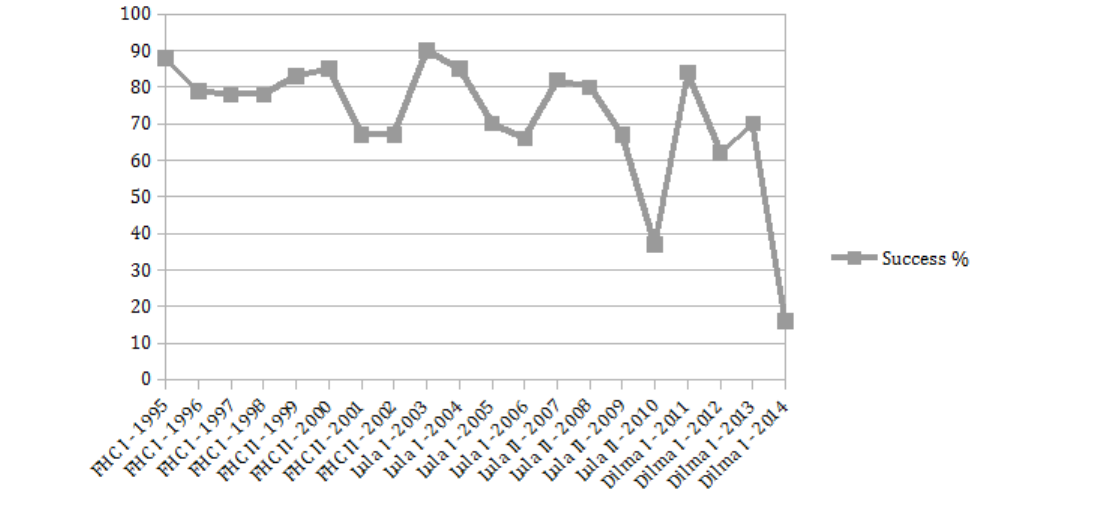
Source: CEBRAP Legislative